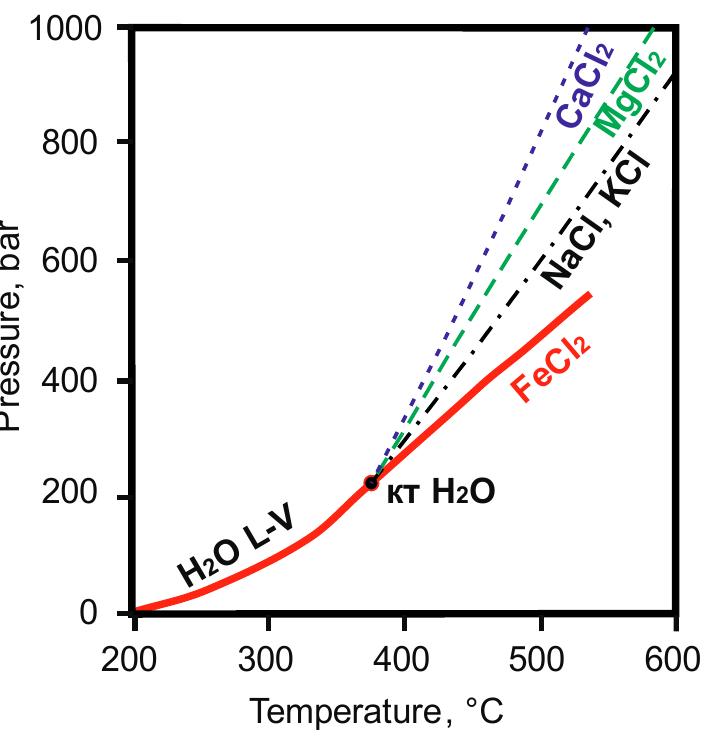
Figure 9. P–T projections of critical curves for water-chloride solutions [41]. L-V—liquid-vapor and KT—critical point.